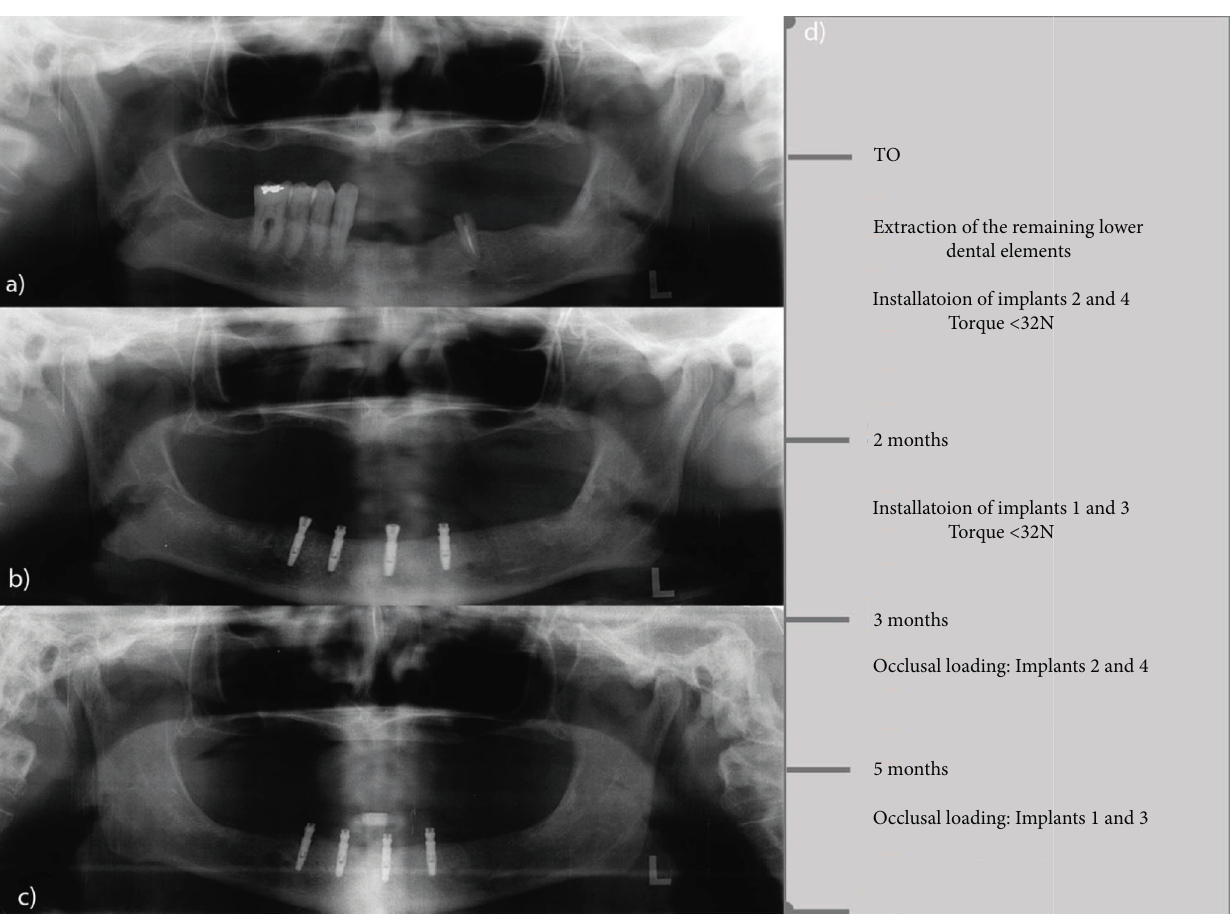
Figure 4: (a) Preoperative panoramic X-rays; (b) panoramic X-rays with installation of implants 2 and 4 (components installed) and implants 1 and 3 (healing caps); (c) fi nal condition after loading all implants; (d) surgical